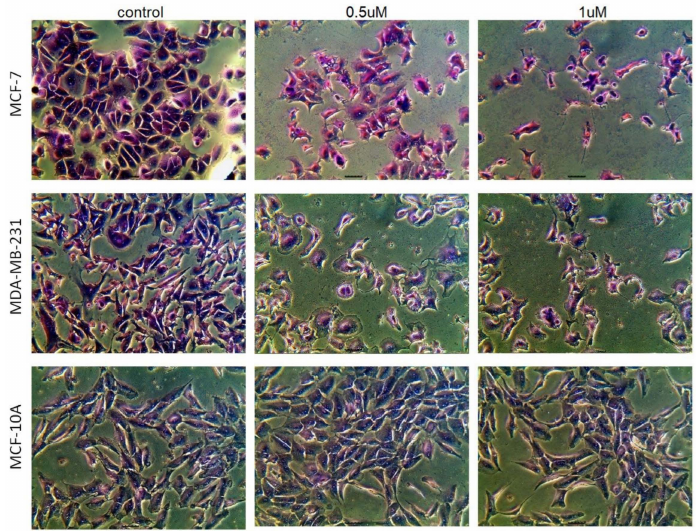
Figure 3. Morphological changes in MCF-7, MDA-MB-231 and MCF-10A cells after 24 h incubation with AJ-418 at concentrations of 0.5 µ M and 1 µ M. After staining with Giemsa dye, the cells were photographed under a light microscope with a built-in camera (magnification 40 ×